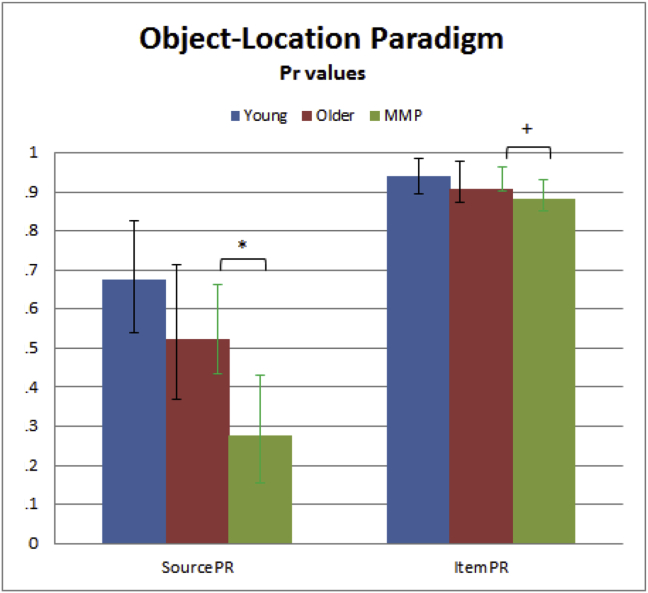
Object-Location Paradigm Source and Item memory Pr values for Young, Older, and Mild Memory Problem (MMP) groups. Group differences are marked * = significant at p < .05 two-tailed; + = significant p < .05 one-tailed for directional hypothesis. Error bars represent two-tailed 95% confidence intervals (after inverse arcsine transformation), after pooling error for a specific comparison of two groups: black bars come from comparison of Young and Older groups while green bars come from comparison of Older and MMP groups.